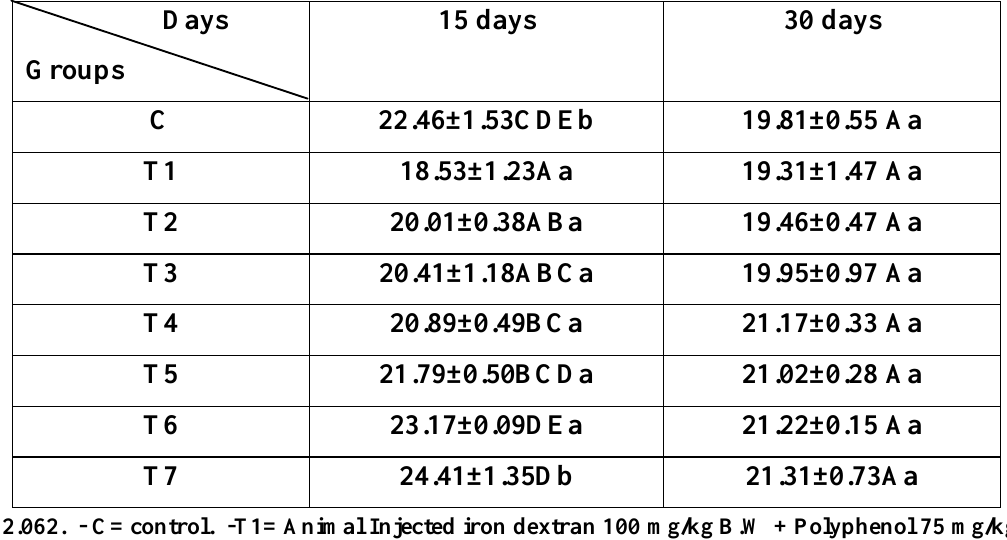
Table 2: Effect of different doses of total polyphenol extracted from Green tea on Serum Albumin concentration (g/L) of iron overload treated